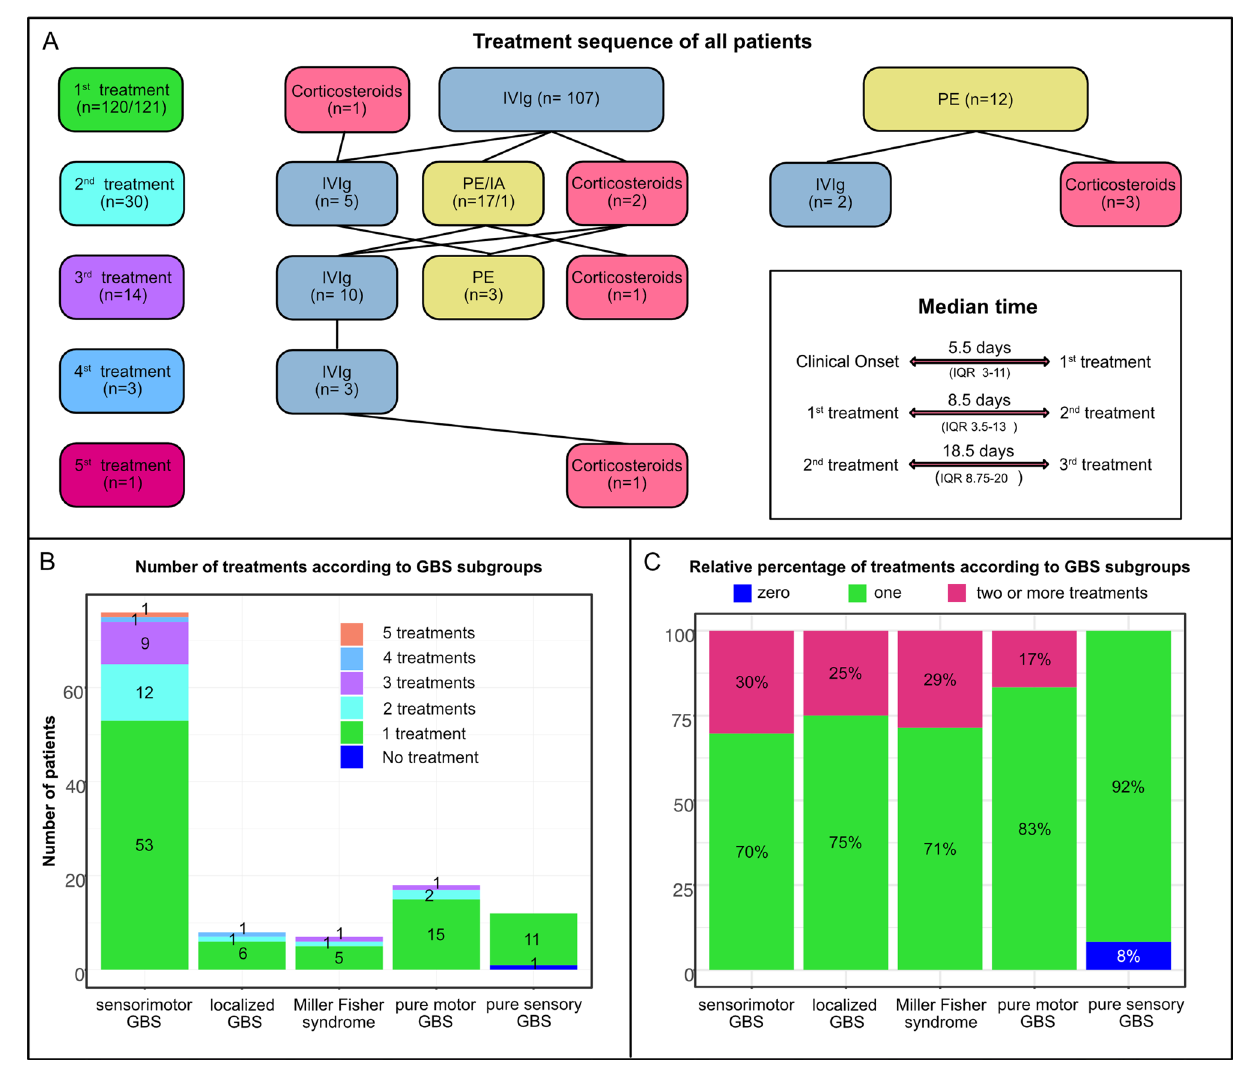
Figure 1. Number of treatments. ( A ) Treatment sequence of all patients included in the study. Rows correspond to sequential treatments (first to fifth) and the overall number of patients per sequential treatment is depicted within the squared boxes on the left column. Type of treatment is indicated by text and color and the respective number of patients receiving a specific treatment modality is shown within the squared boxes. The median time from symptom onset to treatment as well as between treatments with IQR in brackets is shown in the field on the lower right. ( B ) Absolute number of received treatments according to GBS subgroups. ( C ) Relative percentages of received treatments (grouped as zero or one vs. two or more) according to GBS